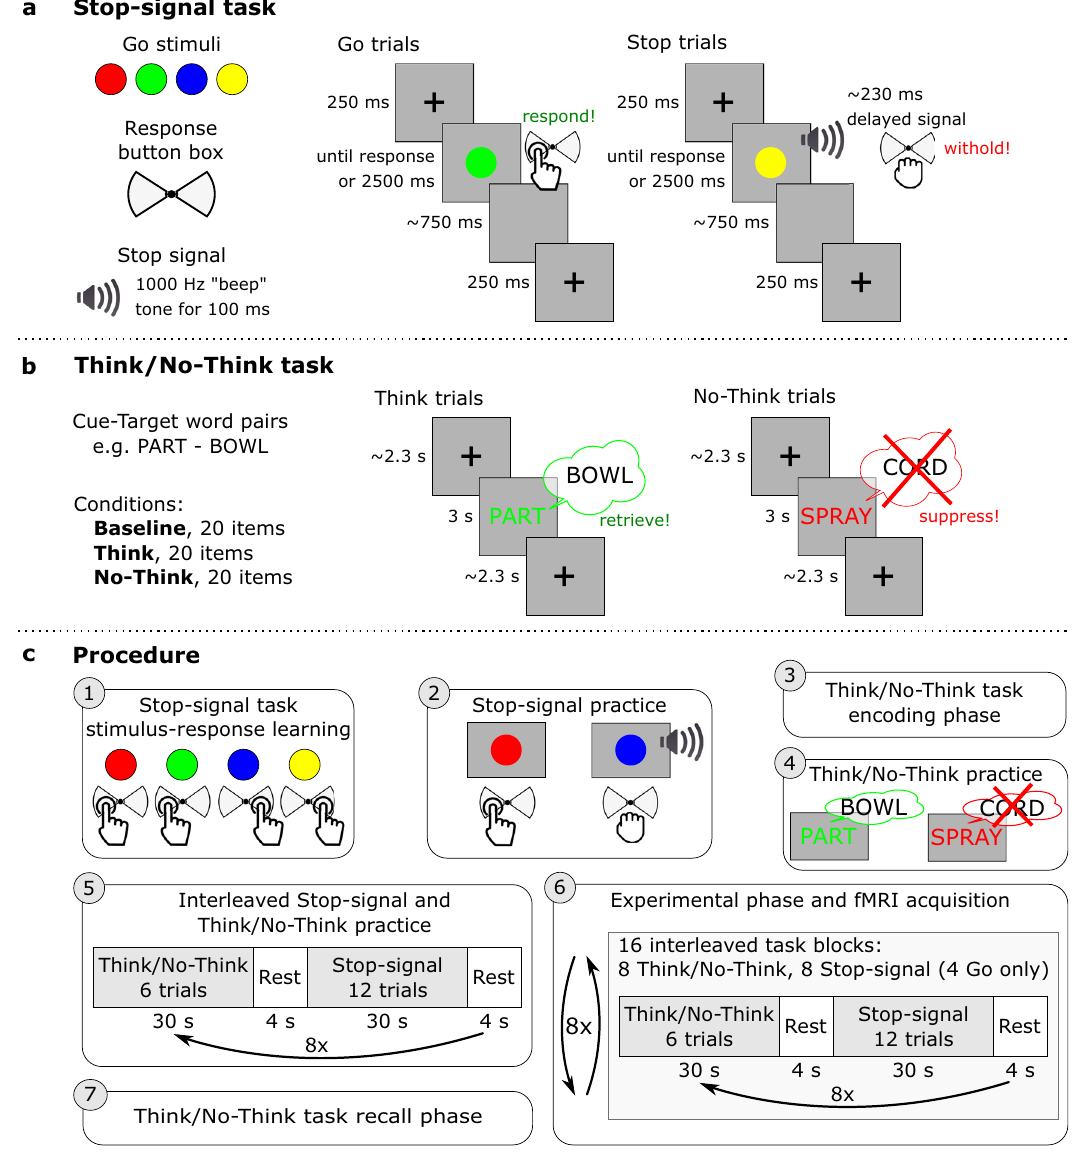
Fig. 2 Schematic of the experimental paradigm and procedure. a In the Stop-signal task, the Go stimuli were red, green, blue, and yellow coloured circles. On Go trials, participants responded by pressing one of the two buttons on a button box according to learned stimulus – response associations. On Stop trials, shortly after the Go stimulus, an auditory “ beep ” tone would signal participants to withhold the button press. The stop-signal delay varied dynamically in 50 ms steps to achieve approximately a 50% success-to-stop rate for each participant. b In the Think/No-Think task, participants learned 78 cue-target word pair associations. Sixty of the word pairs were then divided into three lists composed of 20 items each and allocated to the three experimental conditions: Think, No-Think, and Baseline. During Think trials, a cue word appeared in green, and participants had 3 s to retrieve and think of the associated target word. On No-Think trials, a cue word appeared in red and participants were asked to suppress the retrieval of the associated